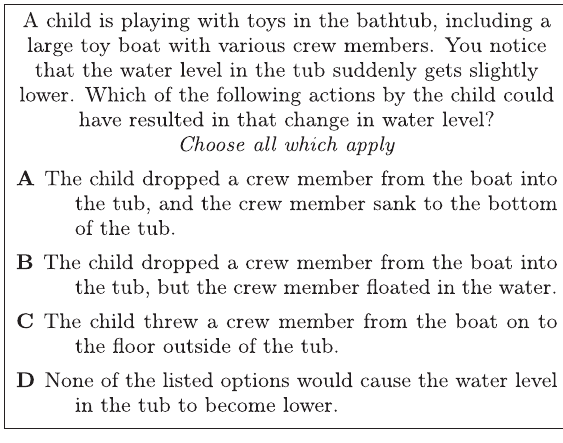
FIG. 2. The boy and tub